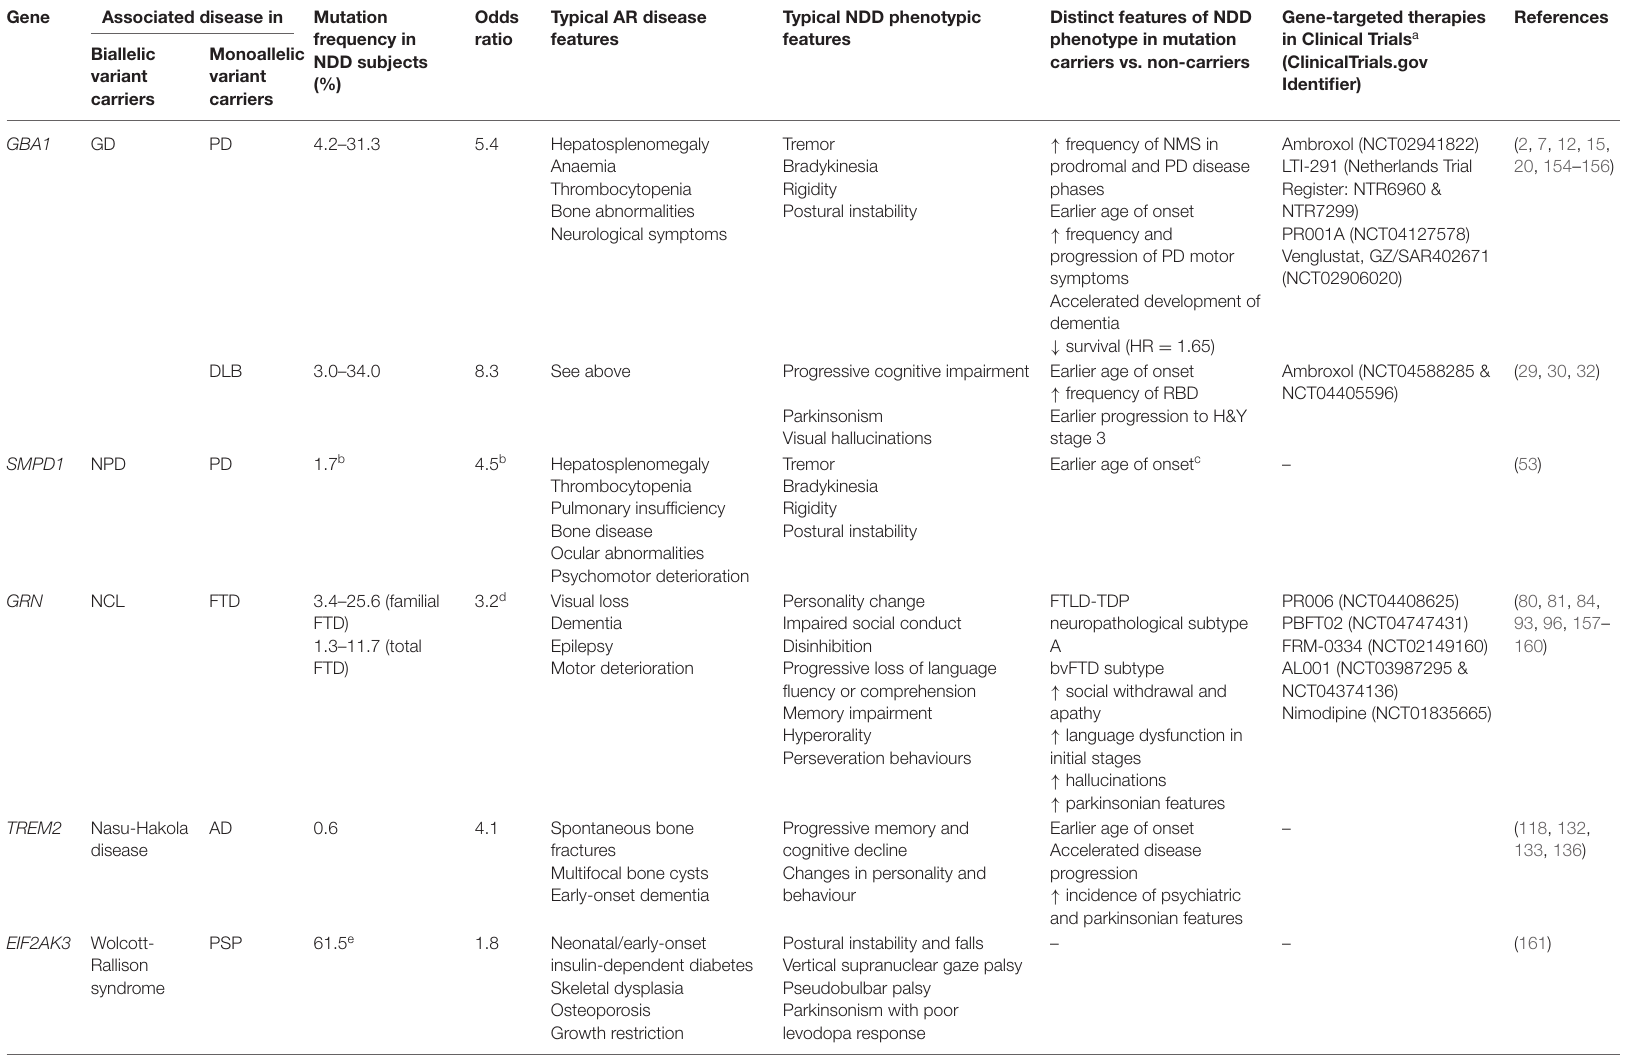
TABLE 2 | Summary table of the main genes associated with AR disease and NDDs (genes with significant evidence supporting association